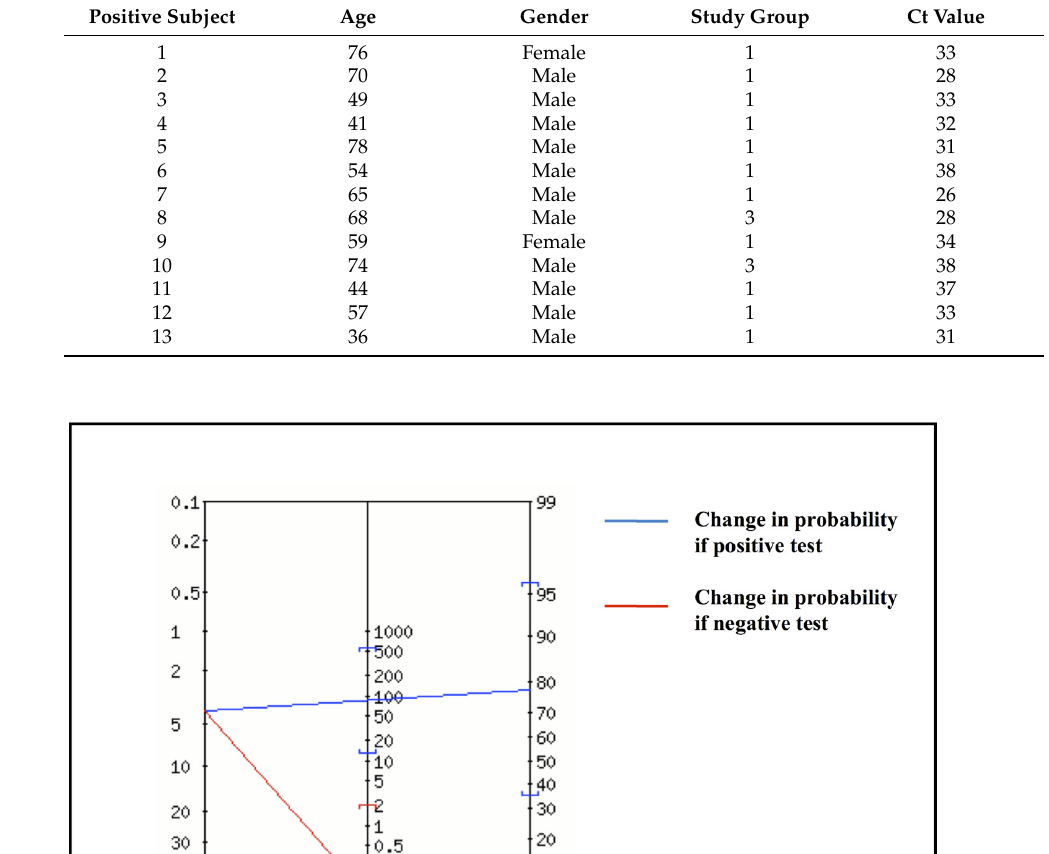
Table 3. Summary of the results of the Ct values of each positive subject included in the study obtained with NeuMoDx™ System. Age and gender included for statistical reasons.